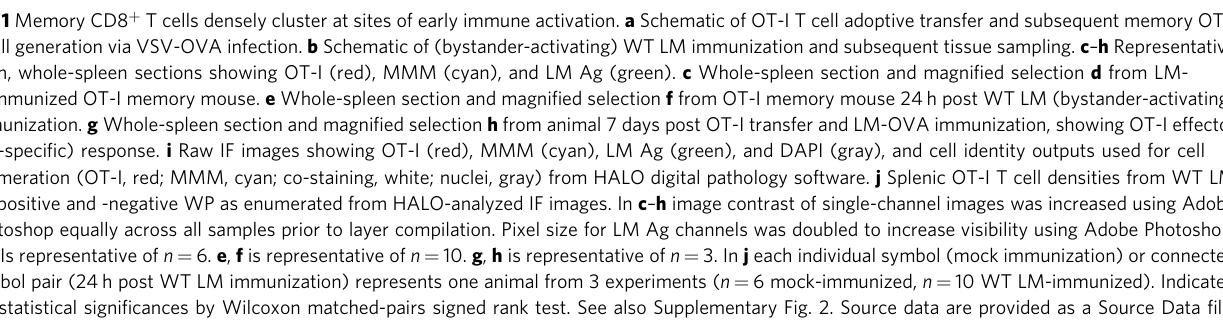
Fig. 1 Memory CD8 + T cells densely cluster at sites of early immune activation. a Schematic of OT-I T cell adoptive transfer and subsequent memory OT-I T cell generation via VSV-OVA infection. b Schematic of (bystander-activating) WT LM immunization and subsequent tissue sampling. c – h Representative 8 µ m, whole-spleen sections showing OT-I (red), MMM (cyan), and LM Ag (green). c Whole-spleen section and magni fi ed selection d from LM- unimmunized OT-I memory mouse. e Whole-spleen section and magni fi ed selection f from OT-I memory mouse 24 h post WT LM (bystander-activating) immunization. g Whole-spleen section and magni fi ed selection h from animal 7 days post OT-I transfer and LM-OVA immunization, showing OT-I effector (Ag-speci fi c) response. i Raw IF images showing OT-I (red), MMM (cyan), LM Ag (green), and DAPI (gray), and cell identity outputs used for cell enumeration (OT-I, red; MMM, cyan; co-staining, white; nuclei, gray) from HALO digital pathology software. j Splenic OT-I T cell densities from WT LM Ag-positive and -negative WP as enumerated from HALO-analyzed IF images. In c – h image contrast of single-channel images was increased using Adobe Photoshop equally across all samples prior to layer compilation. Pixel size for LM Ag channels was doubled to increase visibility using Adobe